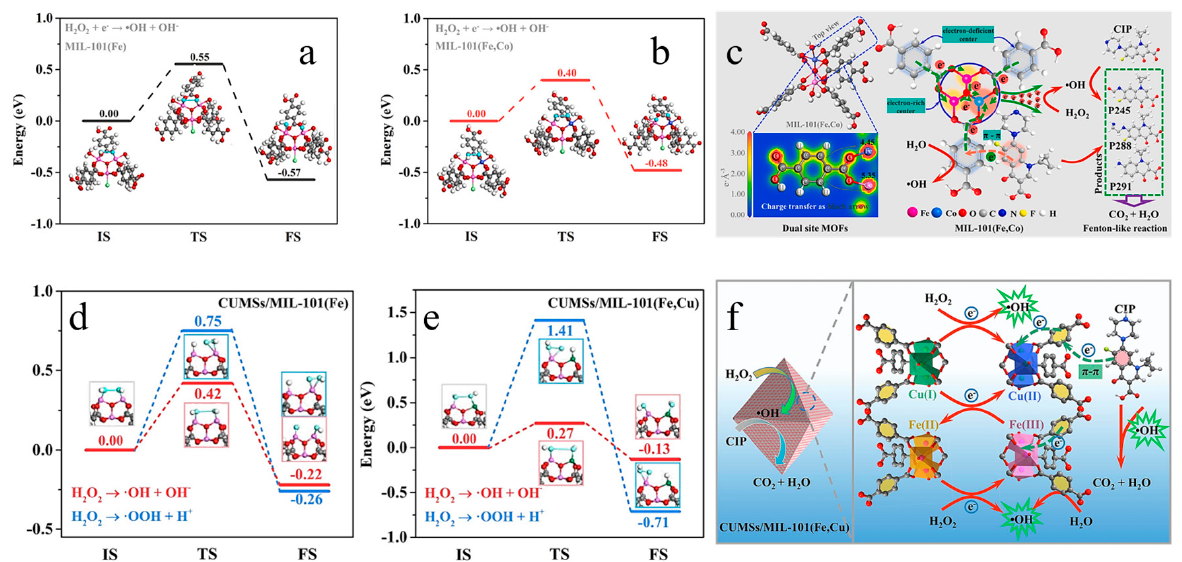
Figure 7. Calculated energy profiles for H 2 O 2 dissociation on ( a ) MIL-101 (Fe) and ( b ) MIL-101 (Fe, Co) surfaces. ( c ) Schematic diagrams of the proposed mechanism involved in CIP degradation by MIL-101 (Fe, Cu)/H 2 O 2 . Adapted with permission from Ref. [71], 2023, Elsevier. Calculated energy profiles for H 2 O 2 dissociation on ( d ) CUMSs/MIL-101(Fe) and ( e ) CUMSs/MIL-101 (Fe, Co) surfaces; ( f ) schematic diagrams of the proposed mechanism involved in CIP degradation by CUMSs/MIL-101 (Fe, Cu)/H 2 O 2 . Adapted with permission from Ref. [72], 2023, Elsevier.